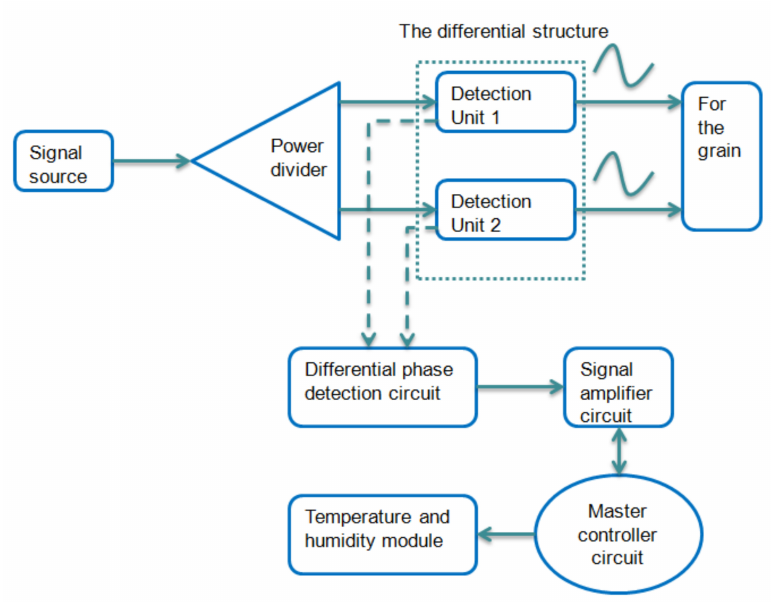
Figure 1. Flowchart of the differential structure of the sensor.